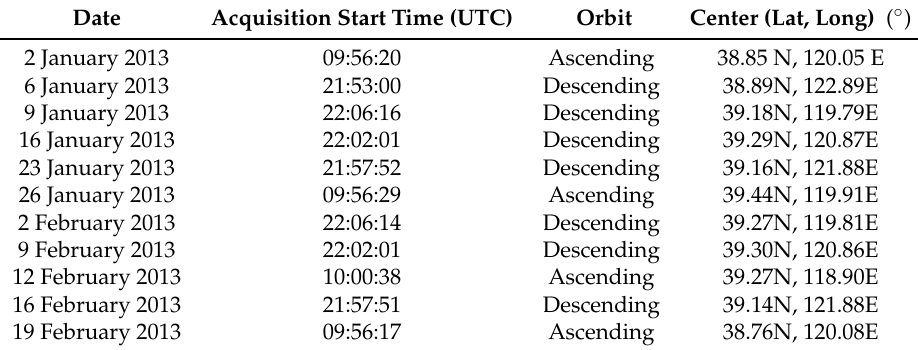
Figure 2. A general diagram of the Bohai Sea sea ice concentration (SIC) and sea ice thickness (SIT) estimation algorithms (green boxes) with used datasets. ECMWF: European Centre for Medium-Range Weather Forecasts; NWP: Numerical Weather Prediction; HIGHTSI: High-Resolution Thermodynamic Snow/Ice mode; HJ-1B; HuanJing-1B; MODIS: Moderate Resolution Imaging Spectroradiometer; SAR: Synthetic Aperture Radar; AMSR2: Advanced Microwave Scanning Radiometer 2. RADARSAT-2 ScanSAR Wide mode SAR imagery acquired over the Bohai Sea in January–February 2013. All the SAR imagery were acquired with HH/HV polarization combination (dual-polarized